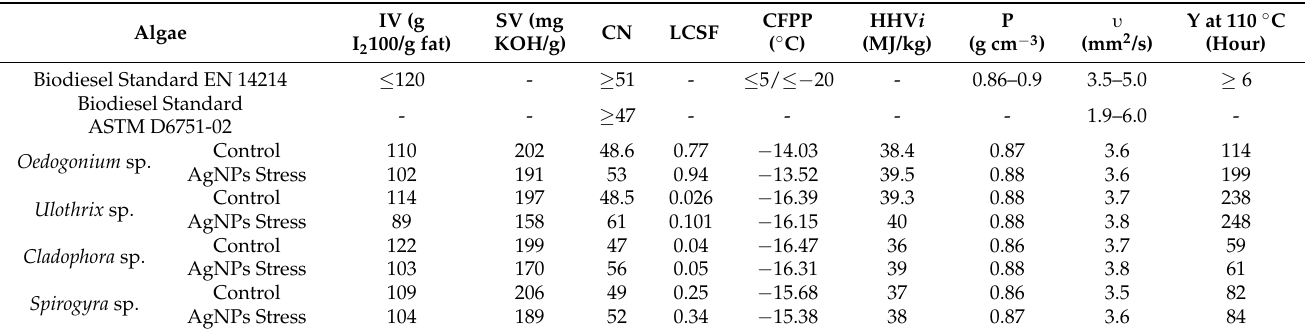
Table 5. Biodiesel properties of algal strains under silver nanoparticle